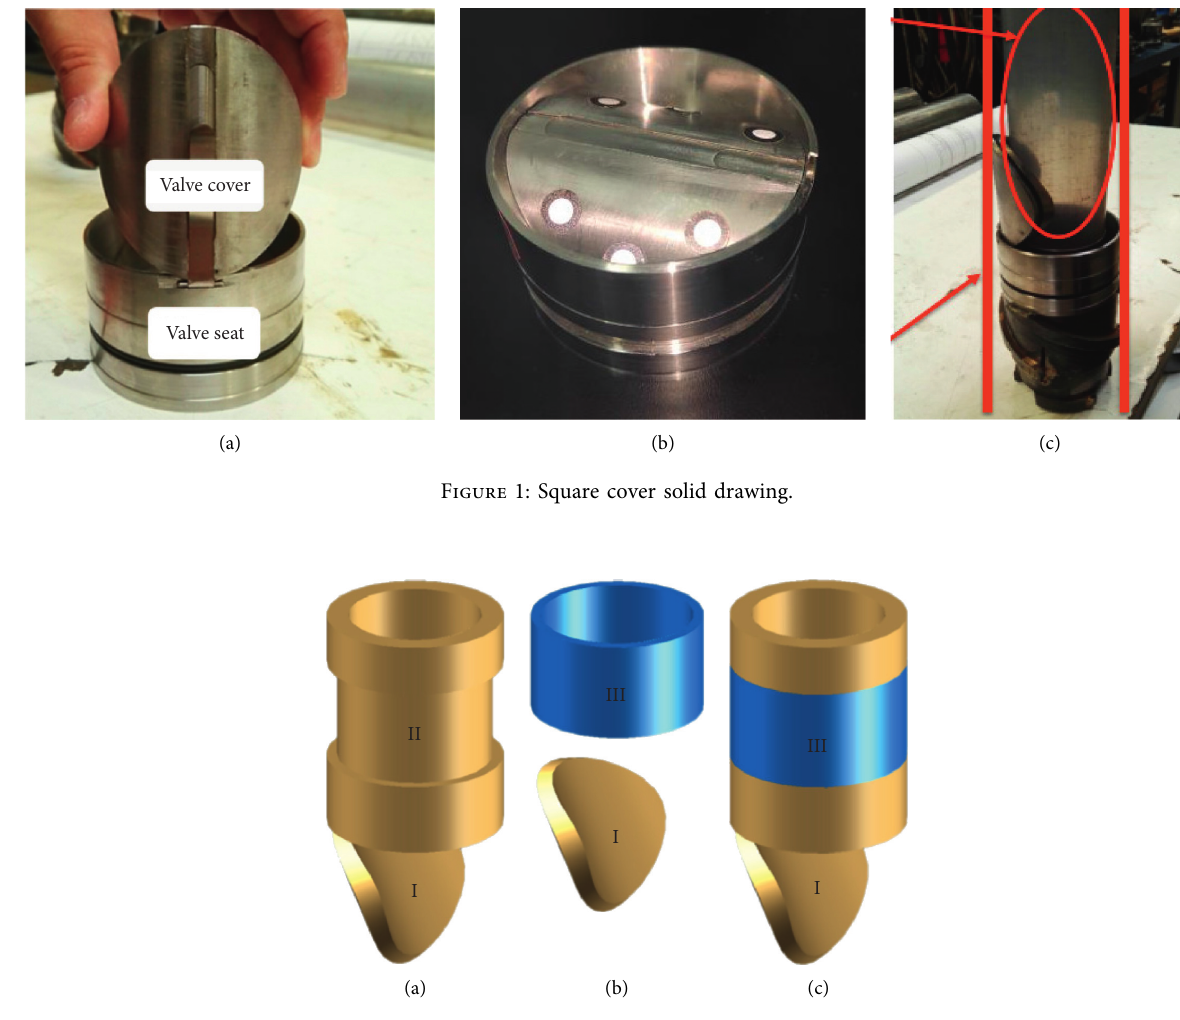
Figure 2: Permanent magnet valve seat design diagram. I, the valve cover. II, the valve seat. III, permanent magnet.